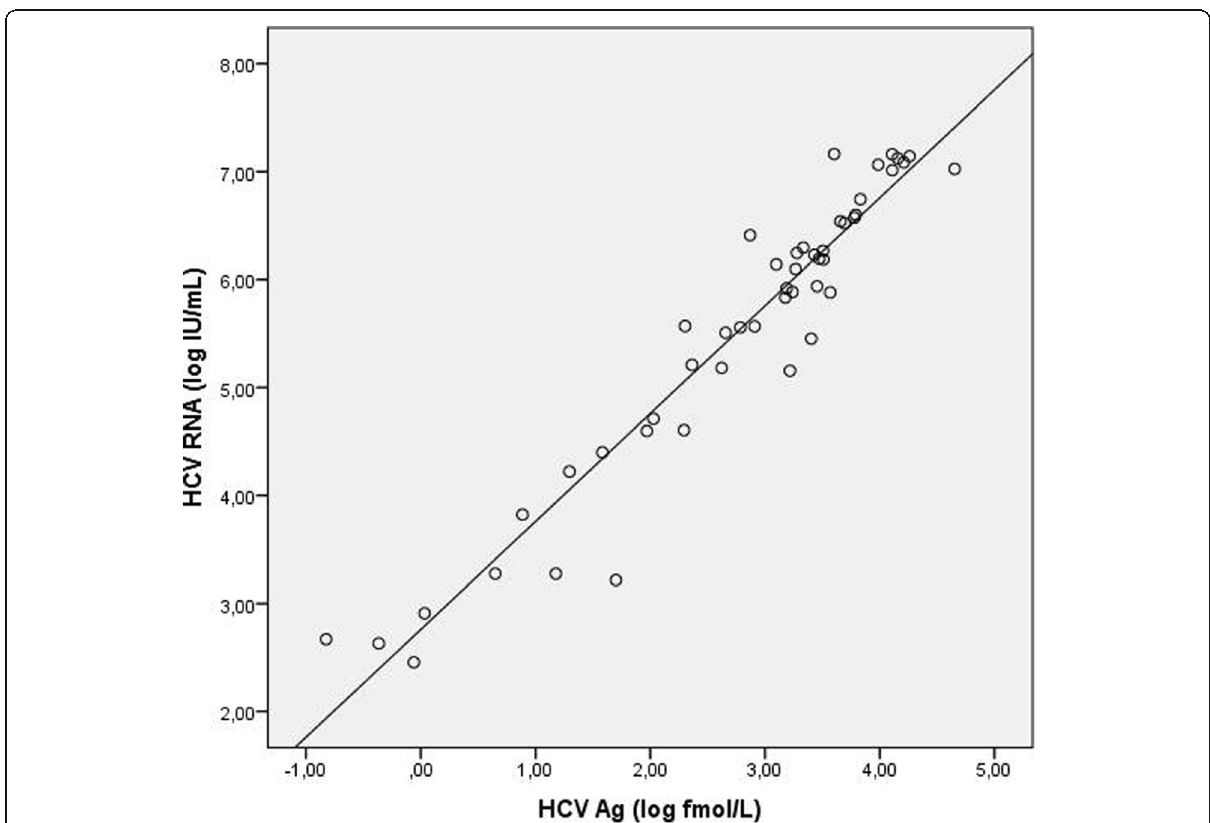
Fig. 1 Correlation diagram of HCV Ag (log10 fmol/L) and HCV RNA (log10 IU/mL), Pearson ’ s correlation ( r = 0.958, p <